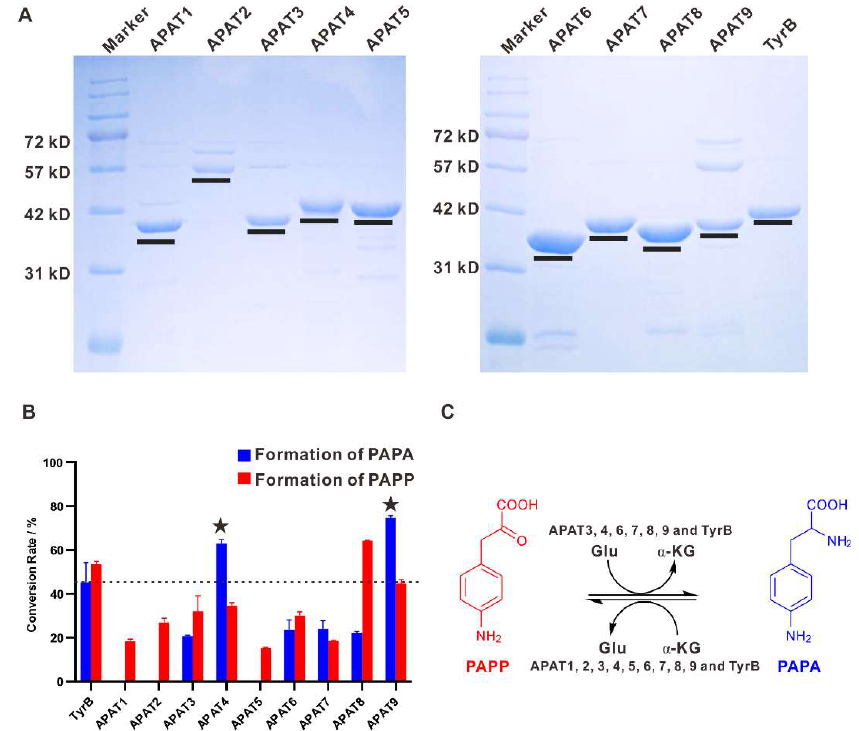
Figure 5. Expression and characterization of APATs and TyrB. ( A ) SDS-PAGE of nine purified APATs and TyrB expressed in E. coli BL21 (DE3). ( B ) Conversion rate analysis of recombinant nine APATs and TyrB in vitro. ( C ) The proposed reversible reactions of APATs and TyrB.